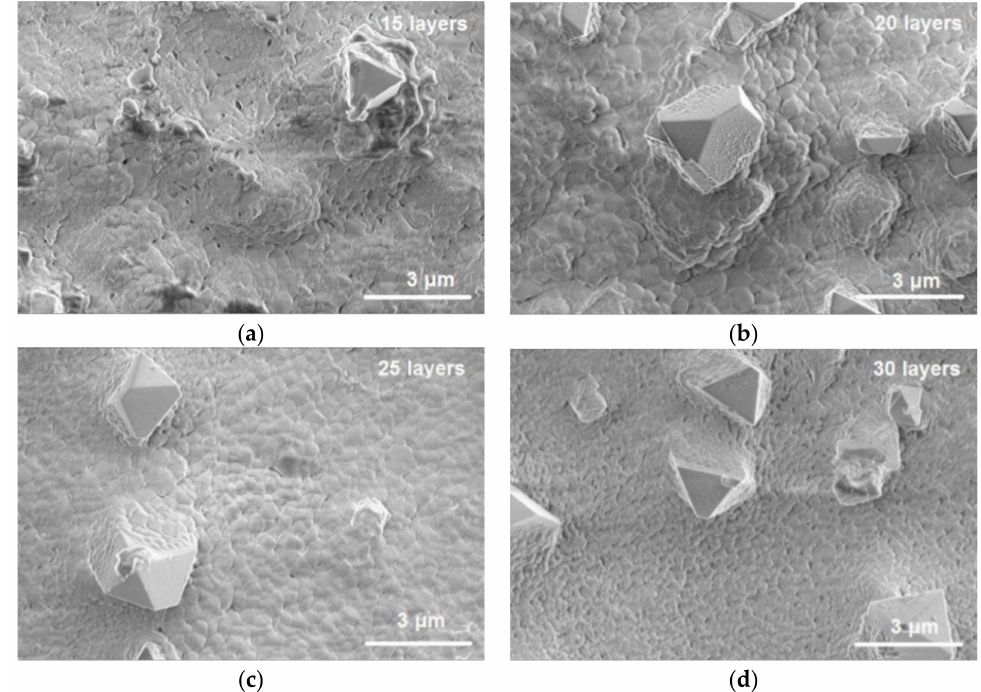
Figure 7. SEM micrographs of the CHA samples containing ( a ) 15, ( b ) 20, ( c ) 25, and ( d ) 30 layers. Magnification 15,000.